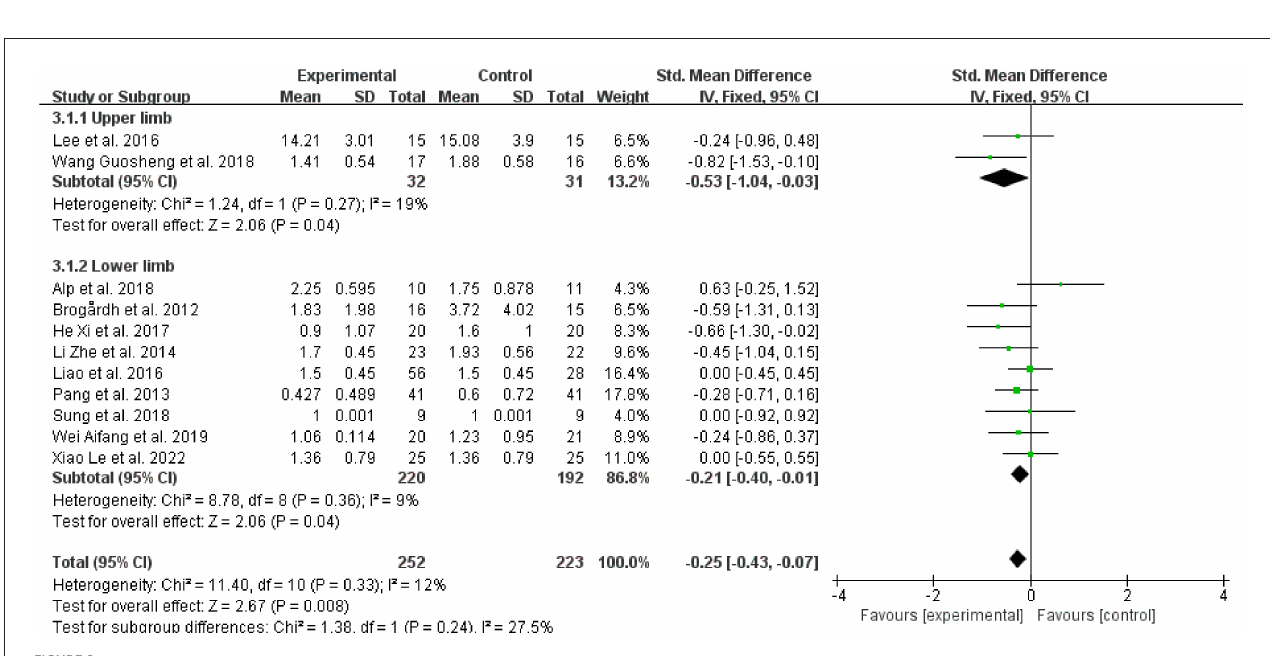
FIGURE8 Forest plot analysis of the efficacy of WBV in subgroups divided on the basis of spasticity